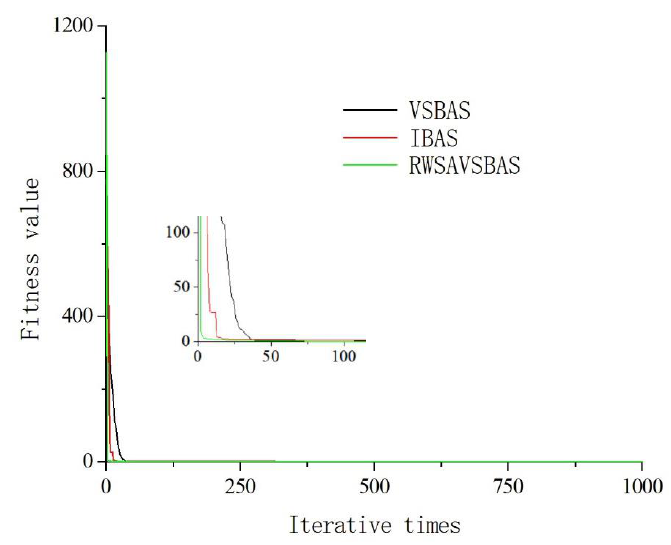
Figure 6. Comparison of the average adaptation curves of each algorithm optimized for 8 iterations.